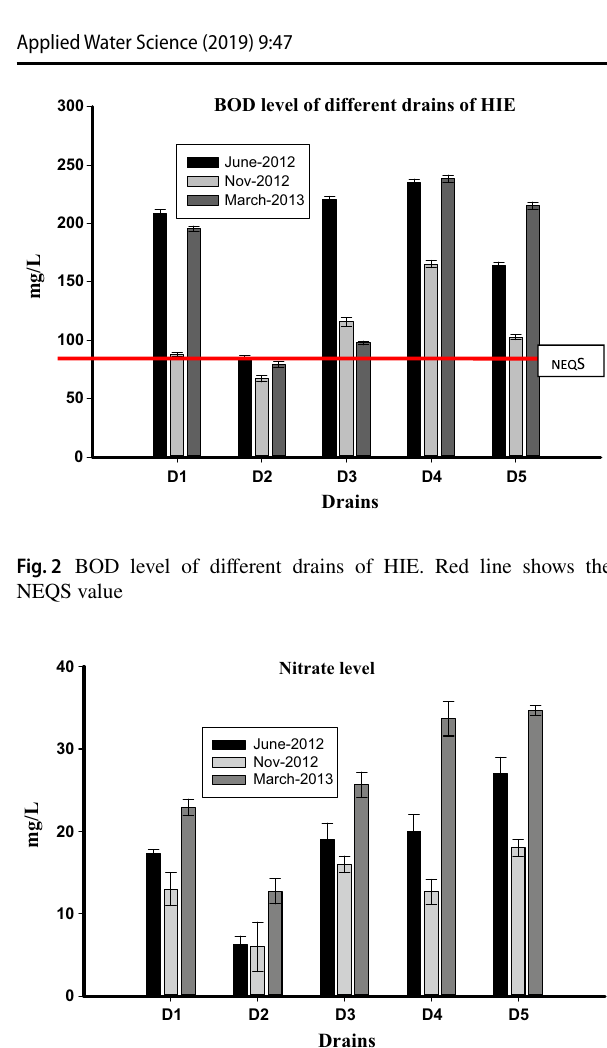
Fig. 5 Phosphate level of different drains of